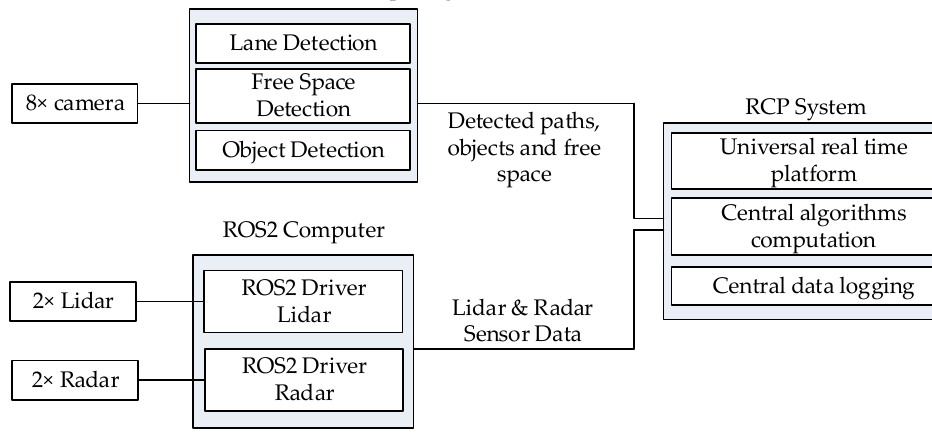
Figure 5. Overview of the connection between the GPU system, the ROS2 computer for sensor integration and the RCP system.